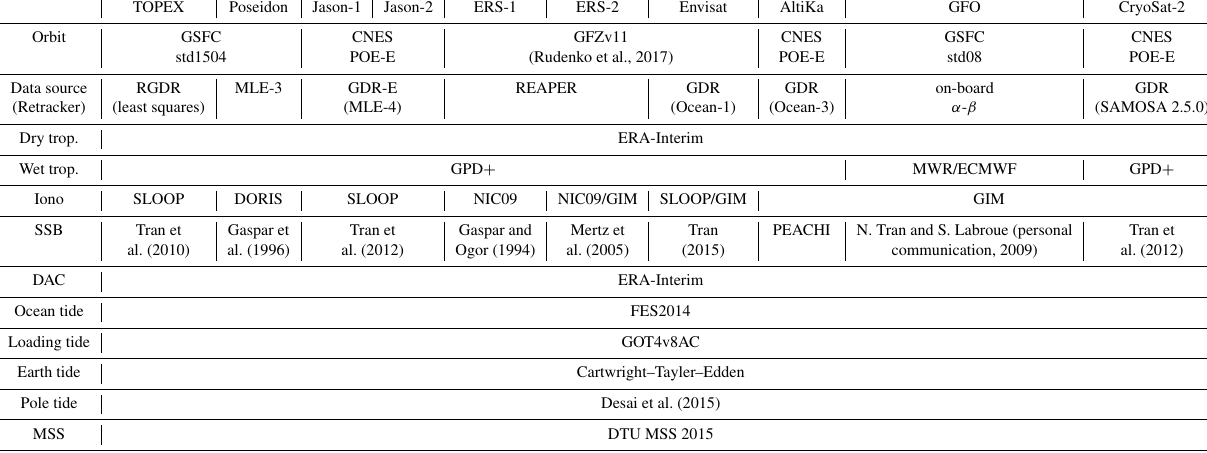
Table 1. Summary of the data sources and the corrections applied to each altimeter instrument.